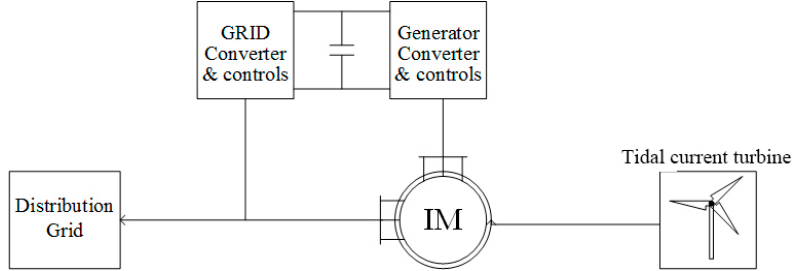
Figure 2. The complete model of doubly fed induction generator (DFIG) tidal current turbine added to the distribution grid. IM: Induction machine. Table 1. 2 MW, 1 kV doubly fed induction generator (DFIG) model parameters [5]. pu: per unit.